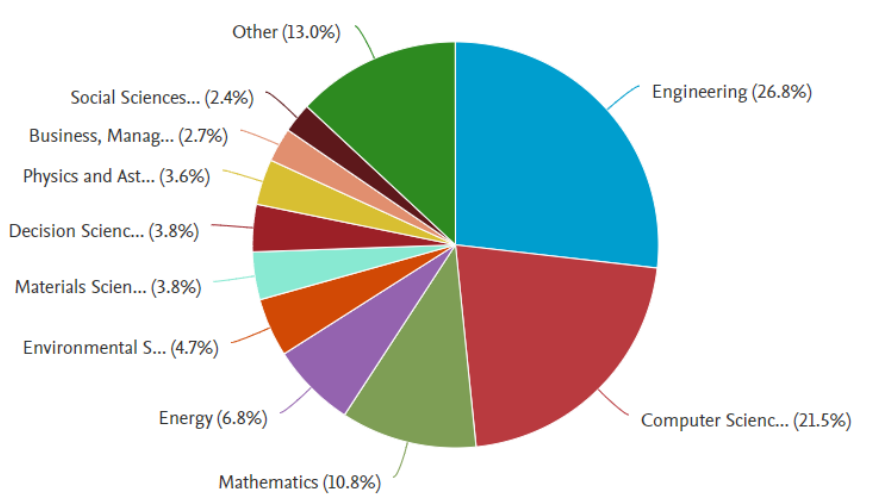
Figure 2. Documents per subject area (source: